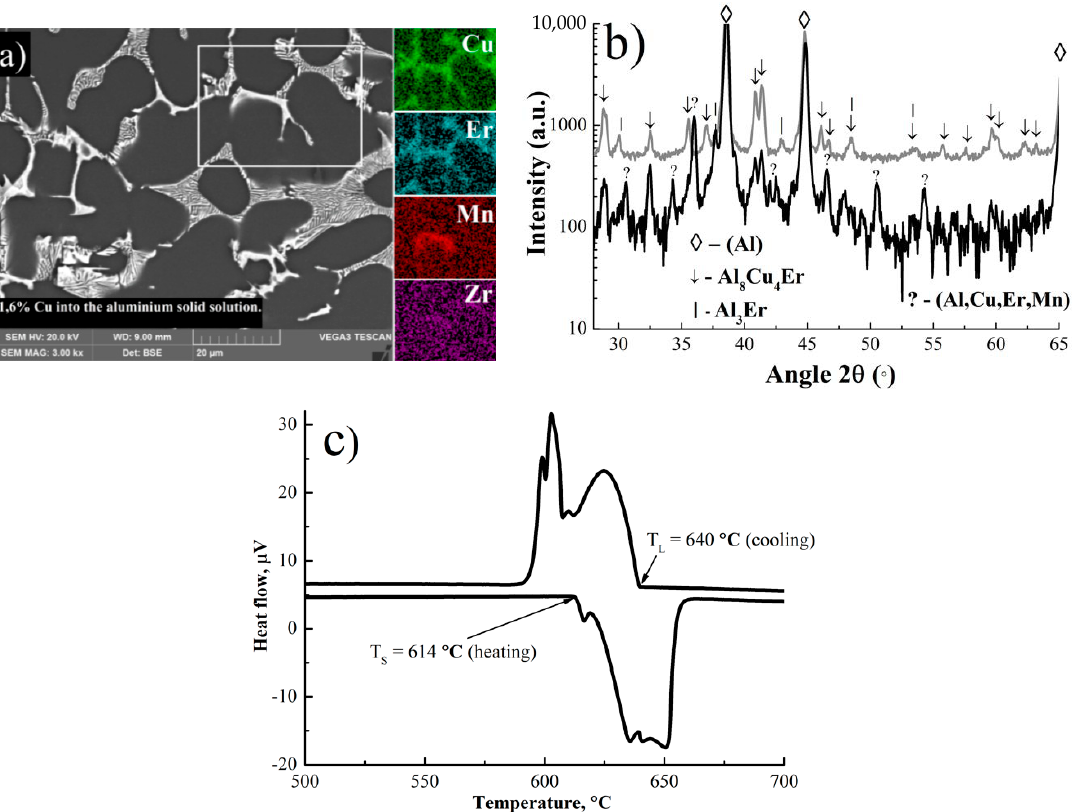
Figure 1. ( a ) As-cast microstructure (SEM), ( b ) XRD patterns of the investigated alloy (black line) in comparison with the Mn-free alloy (grey line), and ( c ) DSC curves.